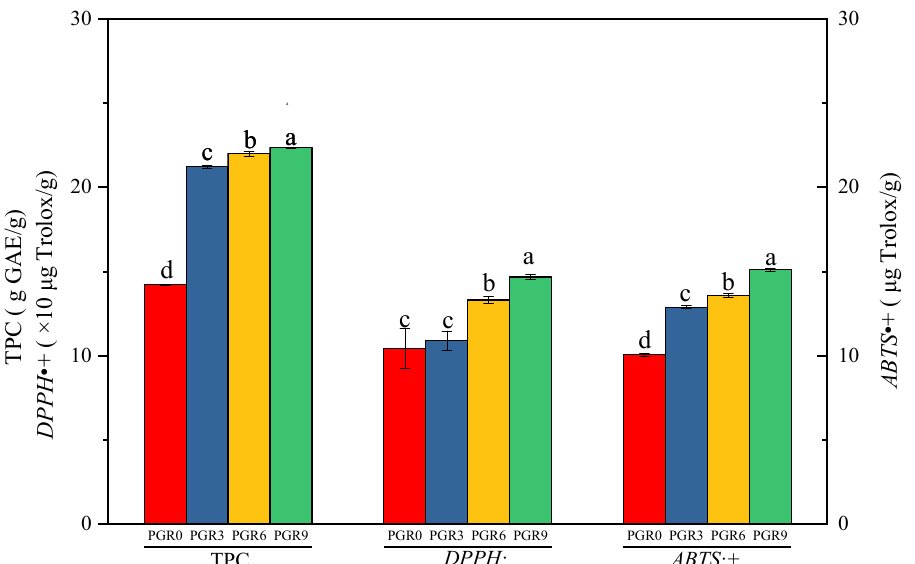
Figure 5. Total polyphenol content (TPC) and antioxidant capacity (DPPH · and ABTS · +) of wheat bread enriched with different addition amounts of PGR flour. PGR0: without PGR flour; PGR3: with 3 g/100 g PGR flour; PGR6: with 6 g/100 g PGR flour; PGR9: with 9 g/100 g PGR flour. Values with different letters are significantly different ( p ≤ 0.05)